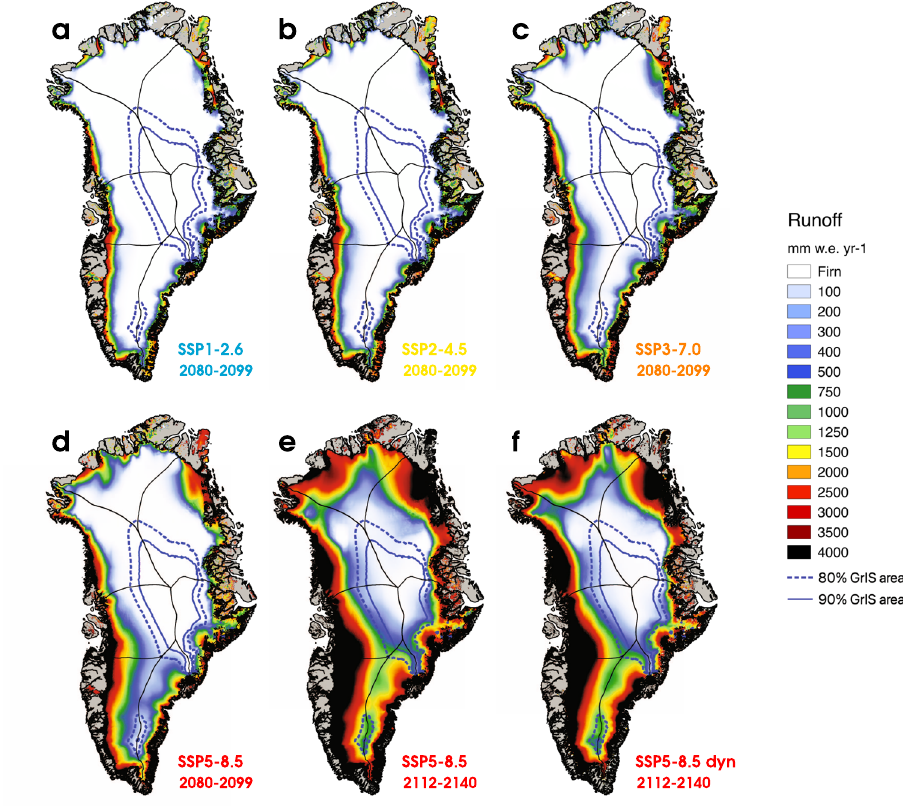
Fig. 4 | GrIS runoff under various warming scenarios. Ensemble-mean down- scaledGrISrunoffat1kmfortheperiod2080 – 2099under a SSP1-2.6(6CESM2and 1RACMO2members), b SSP2-4.5(6members), c SSP3-7.0(5members)and d SSP5- 8.5 (8 CESM2 and 1 RACMO2 members). Downscaled GrIS runoff at 1 km for the